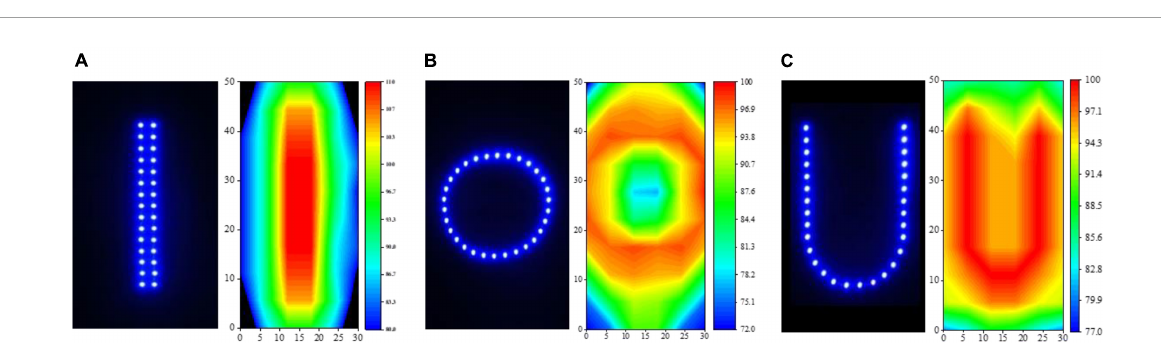
FIGURE6 Three shapes of light source and their light intensity distributions. (A) linear, (B) circular, (C)